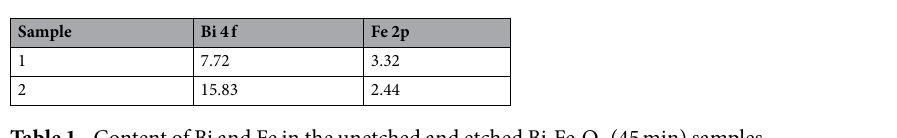
Table 1. Content of Bi and Fe in the unetched and etched Bi 2 Fe 4 O 9 (45 min)